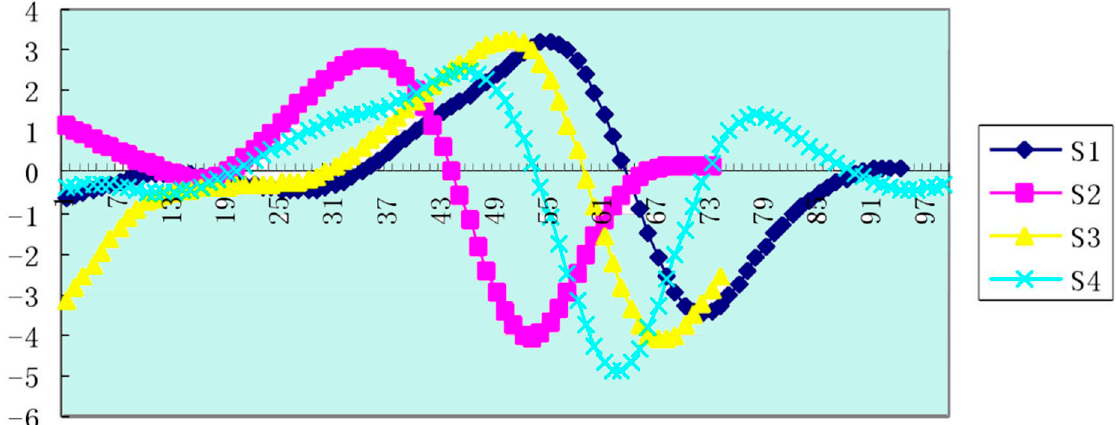
Figure 8. The variation curve of the angular velocities of the thighs of the sample athletes. The abscissa is the time of a swimming cycle, and the ordinate is in radians per second.